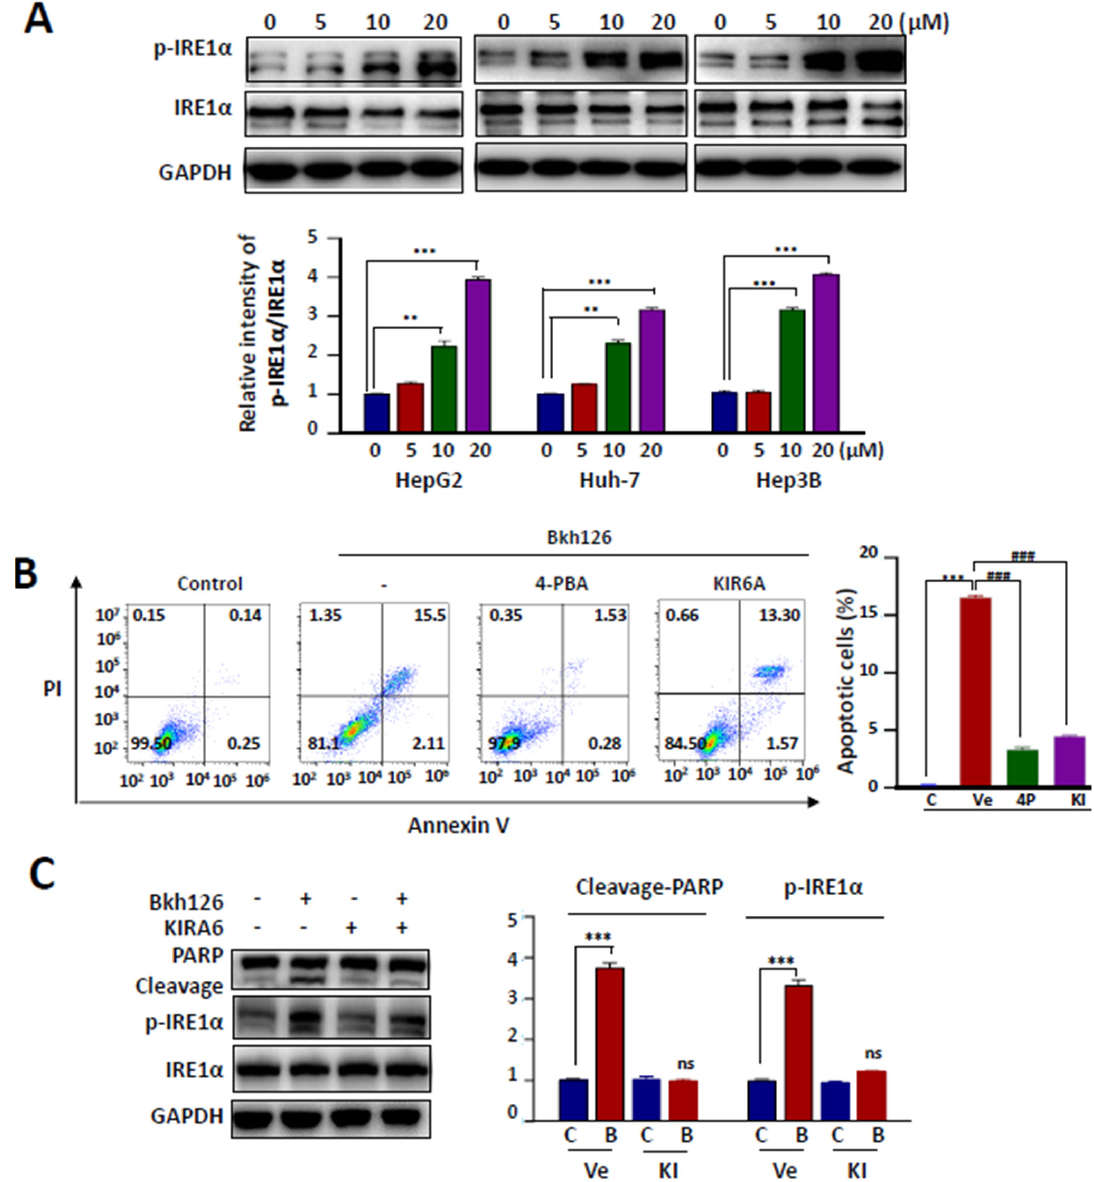
Figure 2. Bkh126 induces ER stress and UPR activation: ( A ) HepG2, Huh-7, and Hep3B were treated with vehicle or Bkh126 (0, 5, 10, and 20 µ M) for 24 h. IRE1 α and p-IRE1 α were determined using Western blotting. The blot intensities were quantified. ( B ) HepG2 cells were treated with 20 µ M Bkh126 alone or in combination with 500 µ M 4-PBA (ER stress inhibitor) or 5 µ M KRIA6 (IRE-1 α inhibitor) for 24 h. Flow cytometry was used to assay the apoptotic rates through Annexin V/PI staining. ( C ) HepG2 cells were pre-treated with 5 µ M KIRA6 (IRE1 α inhibitor) and then 20 µ M Bkh126 for 24 h. The protein expression and phosphorylation of IRE1 α were blotted. The cleavages of PARP were compared. ** p < 0.01, *** p < 0.001, and ### p < 0.001. ns, not significant; C, control; B, Bkh126.